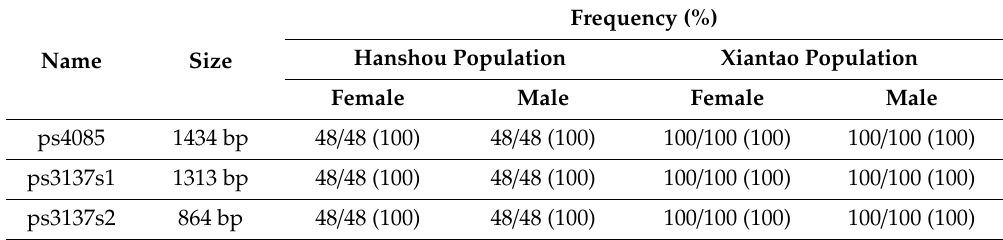
Table 4. Comparison result of sex identification using gonadal tissue observation and markers in two Pelodiscus sinensis